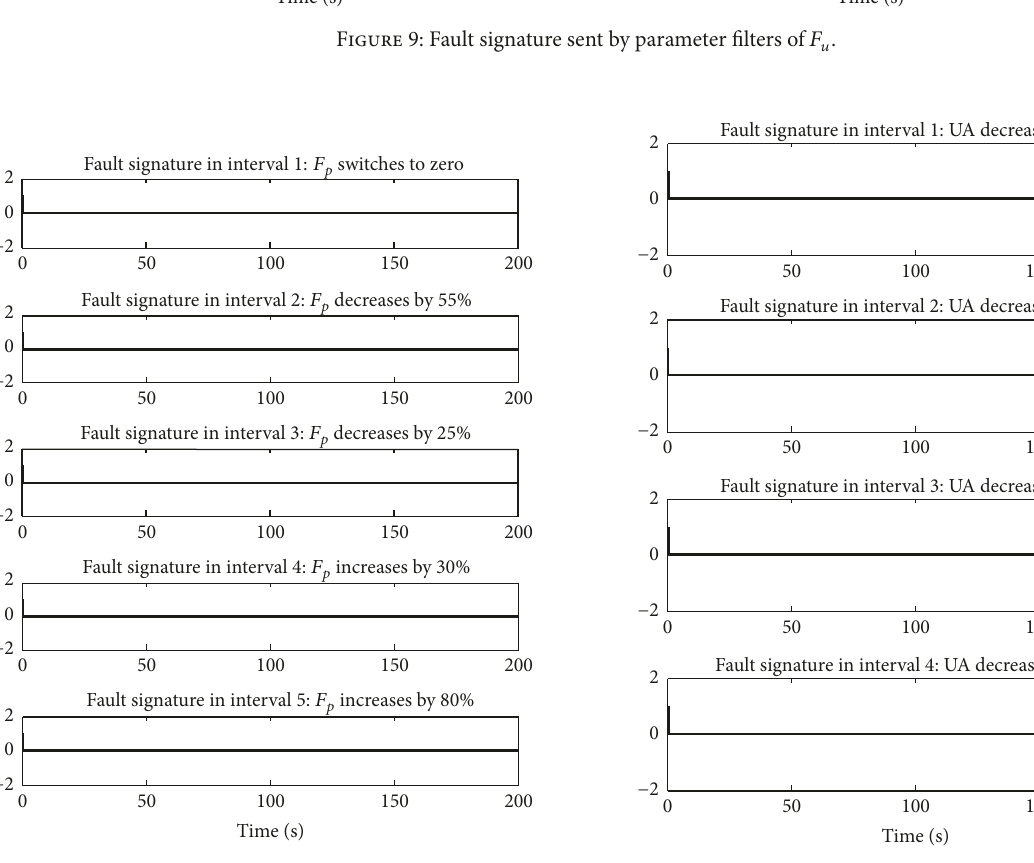
Figure 10: Fault signature in parameter filters of 𝐹 𝑝 . Figure 11: Fault signature in parameter filters of